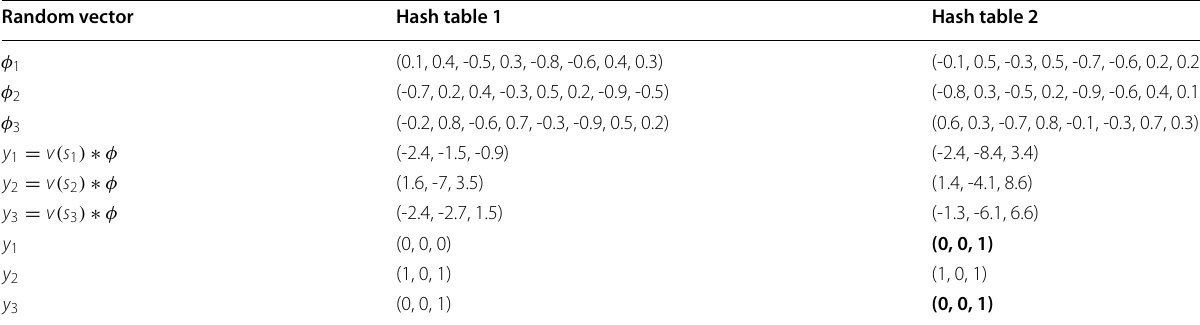
Random vector Hash table 1 Hash table